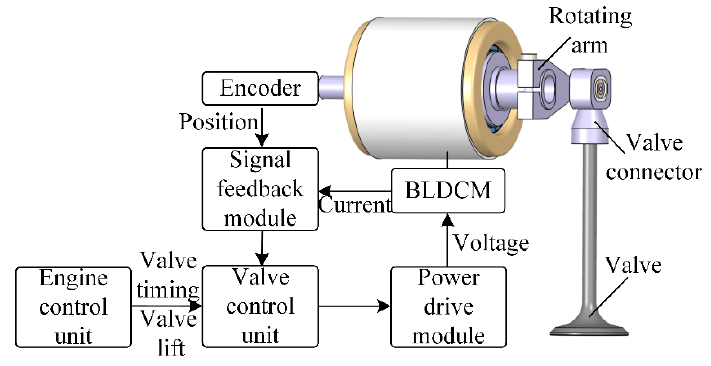
Figure 2. Structure of the FVVA system.